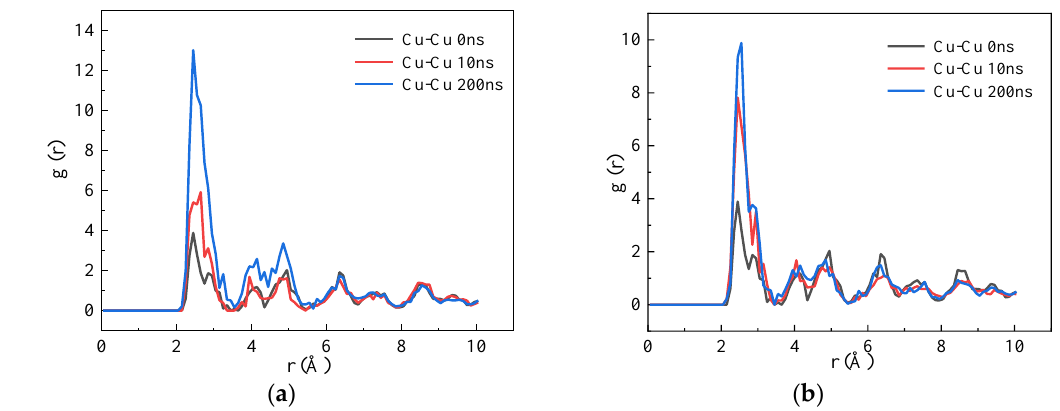
Figure 7. The radial distribution function of Fe-3.5Cu alloy with 0.1 at% and 0.2 at% vacancies at different aging time ( a ) Fe-3.5Cu-0.1V alloy ( b ) Fe-3.5 Cu-0.2V alloy.